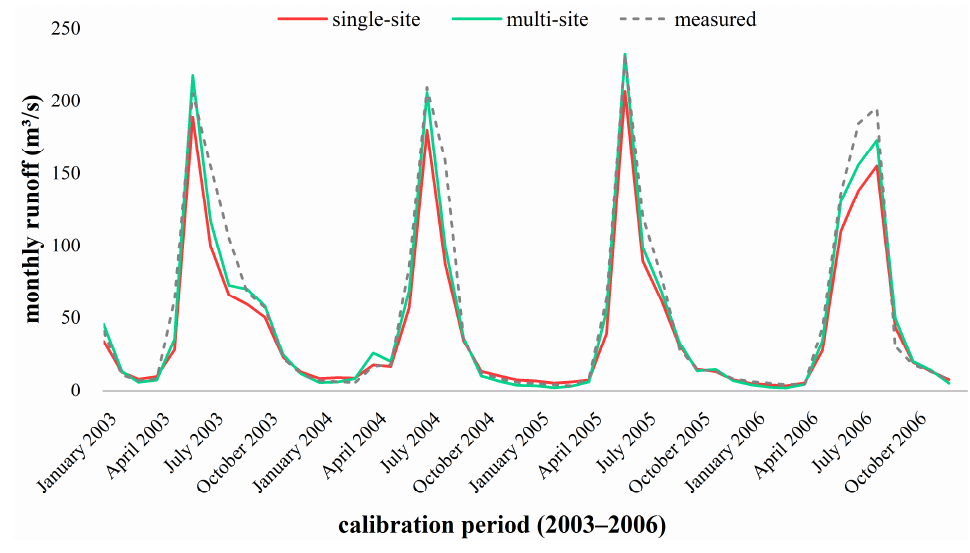
Figure 6. Monthly simulated runoff during the calibration period.